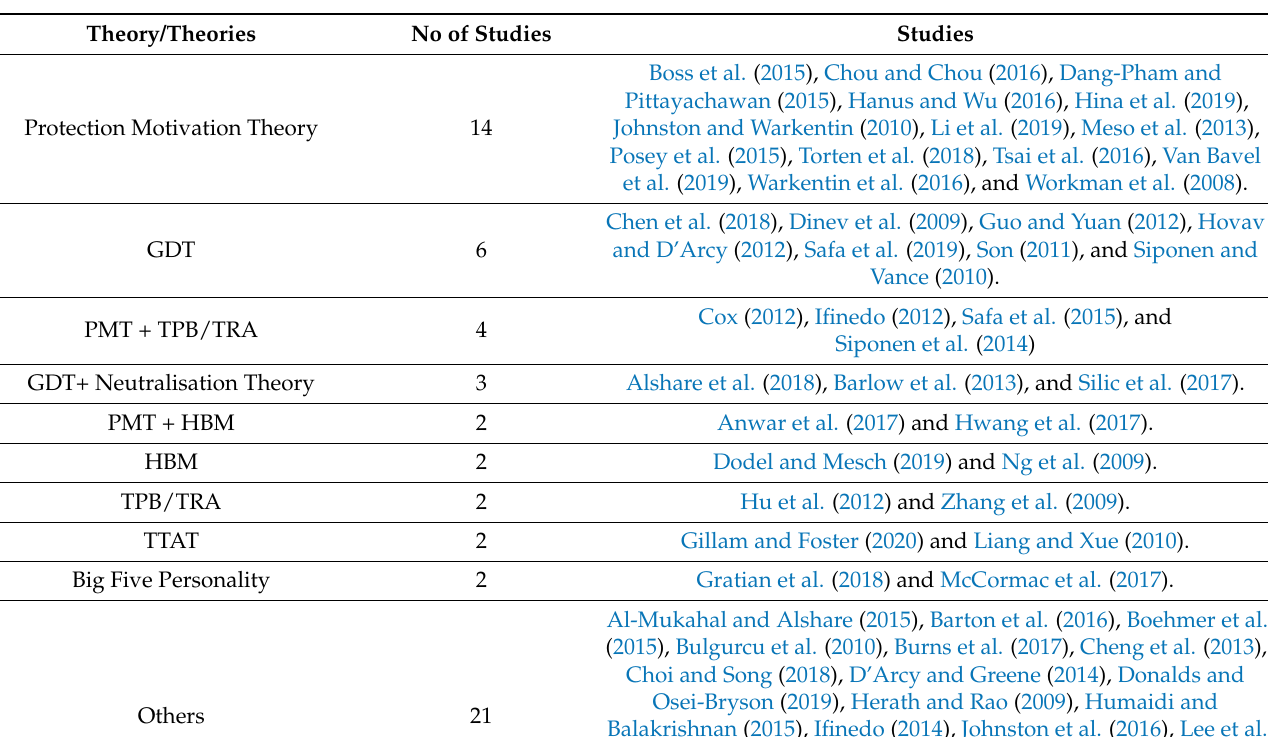
Table 4. Theories adapted in the